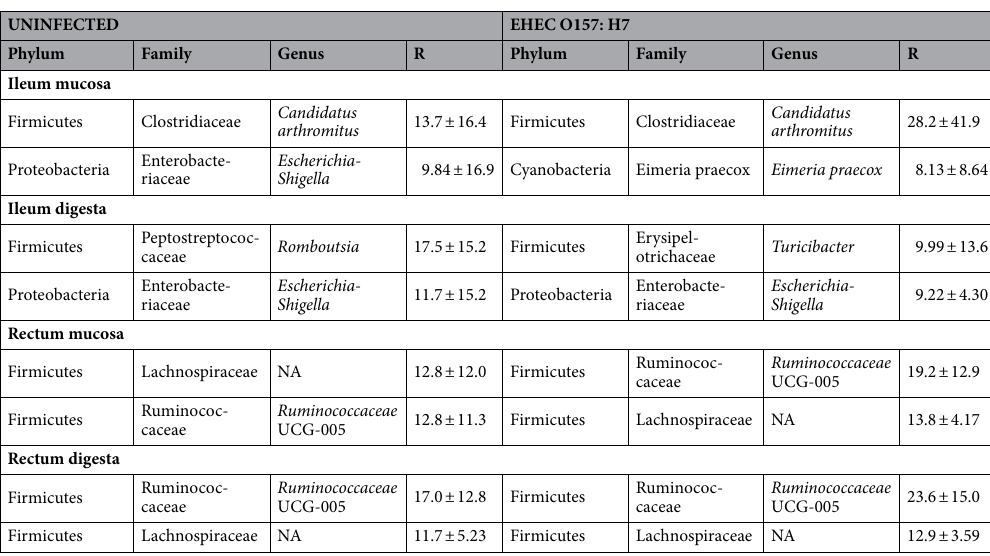
Table 1. Taxonomic composition of most relative abundant bacteria in ileum mucosa, ileum digesta, rectum mucosa, and rectum digesta (4 locations) from uninfected and EHEC O157: H7 infected groups (R: relative abundance %, expressed as mean ± standard